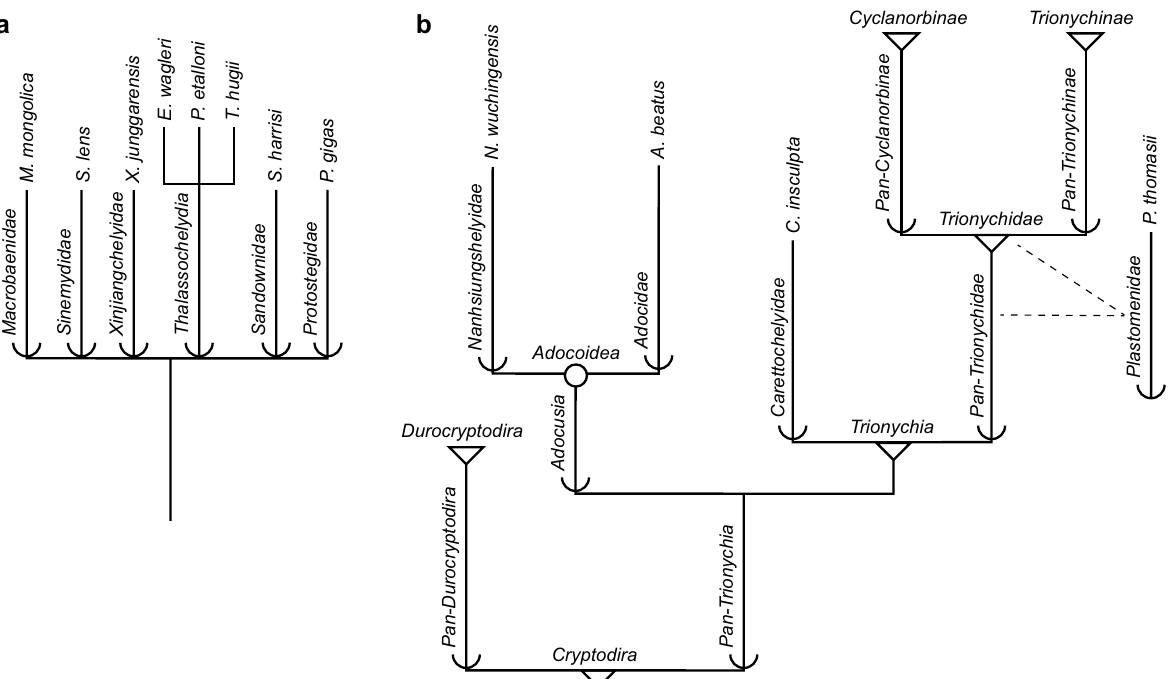
Fig. 3 Simplified diagrams that highlight the proposed name usage of clade names within a Mesozoic turtle clades with uncertain affiliations and b